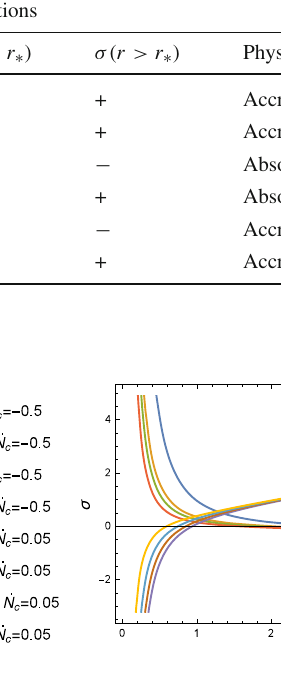
Fig. 14 Left figure: the radiation-accretion density σ versus the dis- tance r for some typical constant values ˙ M and ˙ N c values for (cid:5) = − 1 in the cosmological background. In the four upper cases, the accretion density is an increasing function from negative to positive values. In the four lower cases, the radiation density is a decreasing function from positive values to negative values. Then, for a dynamical cosmological background, if the condition | ˙ N c ( u ) | (cid:11) | ˙ M ( u ) | is not met, the posi- tive energy condition is violated in some regions of spacetime. Right